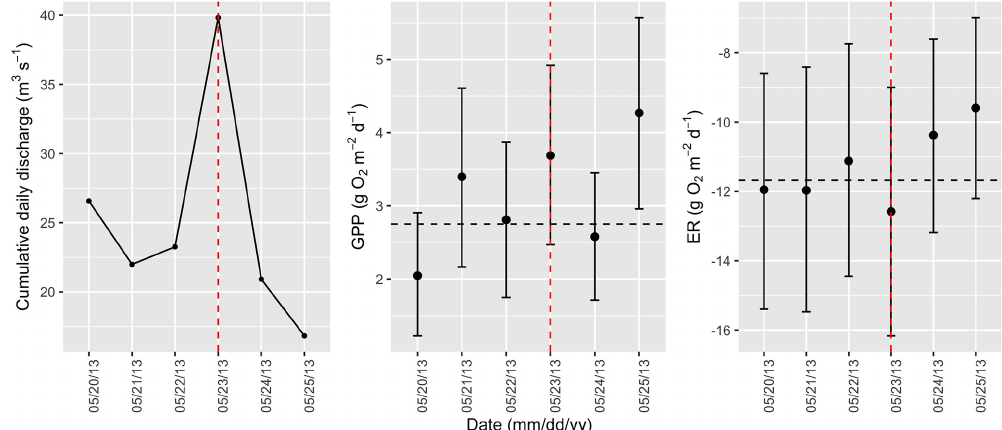
Figure A6. Cumulative daily discharge and metabolism (gross primary production and ecosystem respiration; GPP and ER) time series for the Stroubles Creek flow event on 23 May 2013 (noted with a dashed vertical red line in all three panels). The dashed horizontal black lines are mean values of GPP and ER prior to the high flow event. Error bars for posterior estimates of GPP and ER are 2.5% and 97.5% Bayesian credible intervals.